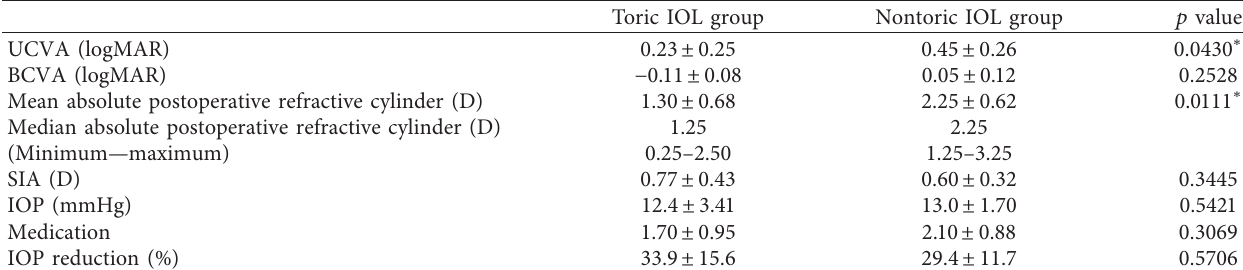
Table 2: Postoperative visual acuity, astigmatism, and IOP at 3 months in the toric IOL and the nontoric IOL